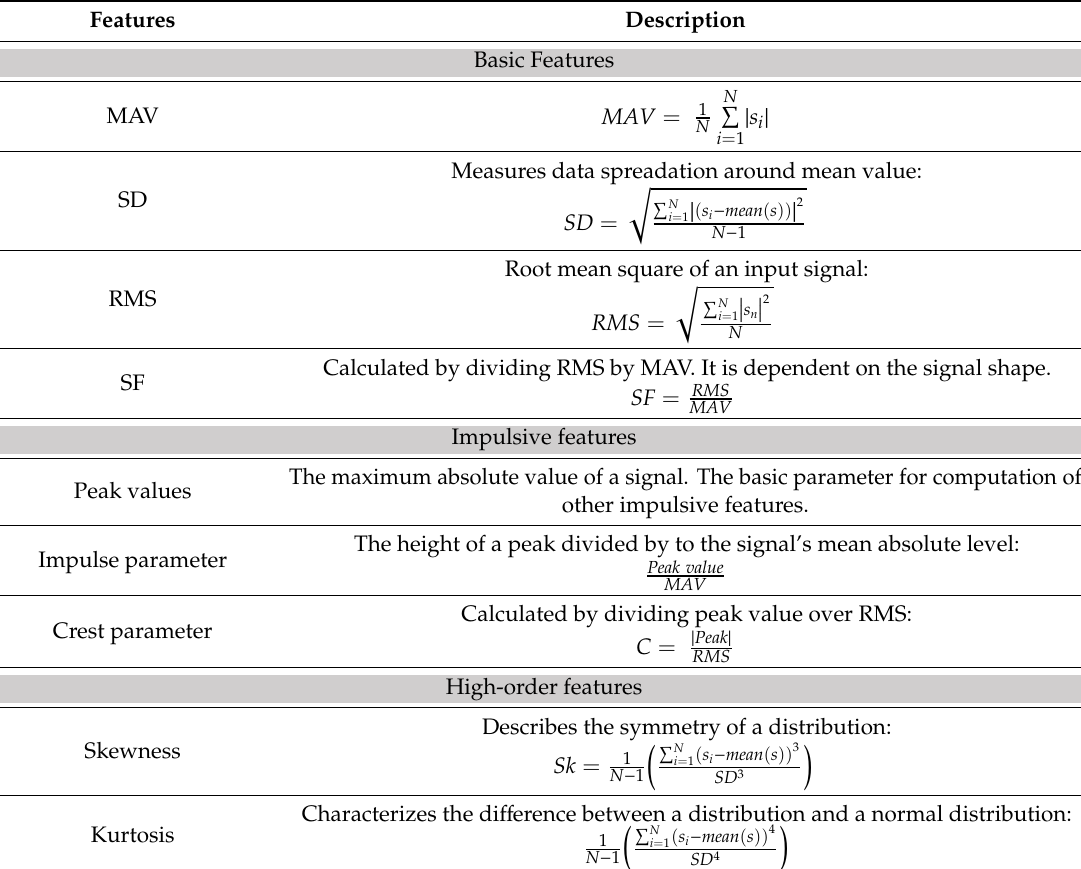
Table 3. Description of statistical features. In the following equations, N presents the total data points in signal s , s i defines the i -th value in the signal s